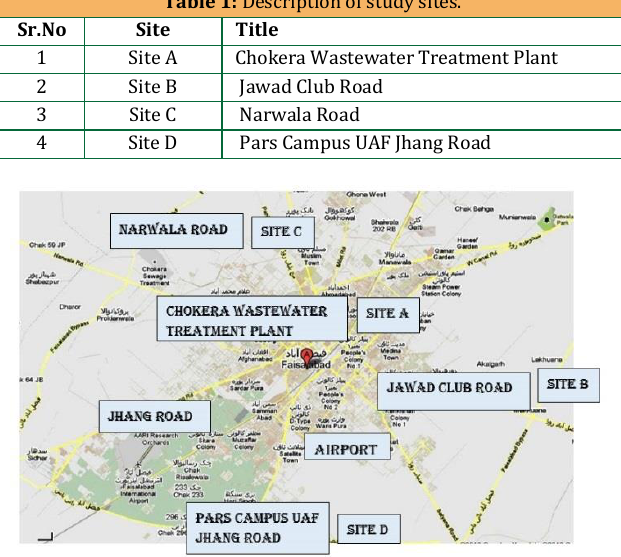
Figure 1: Site Map and Sampling